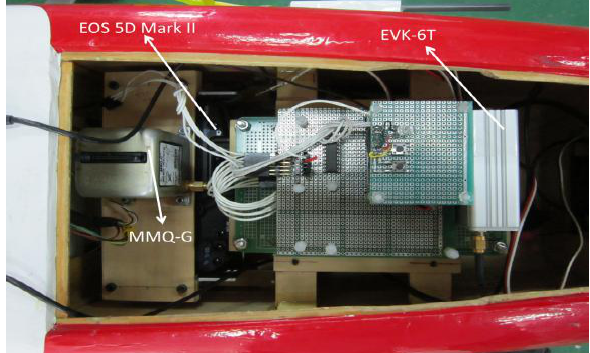
Figure 2. Configuration of DG module